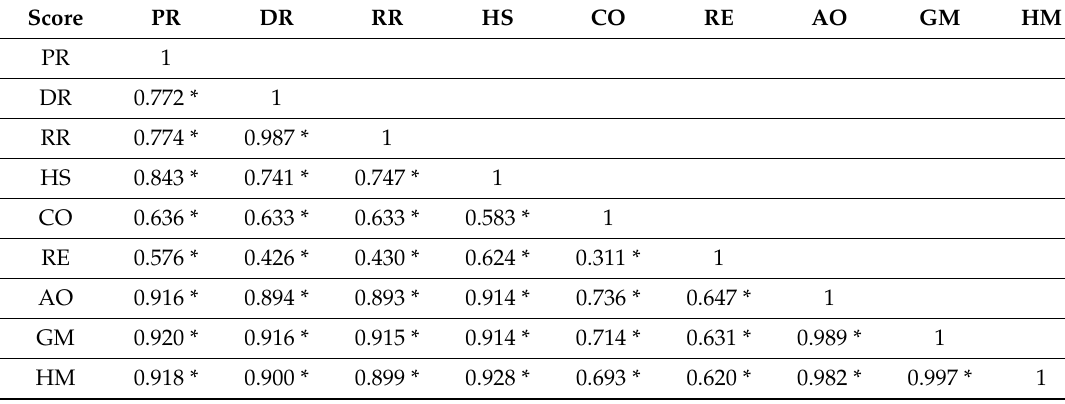
Table 2. Correlations of numerical score